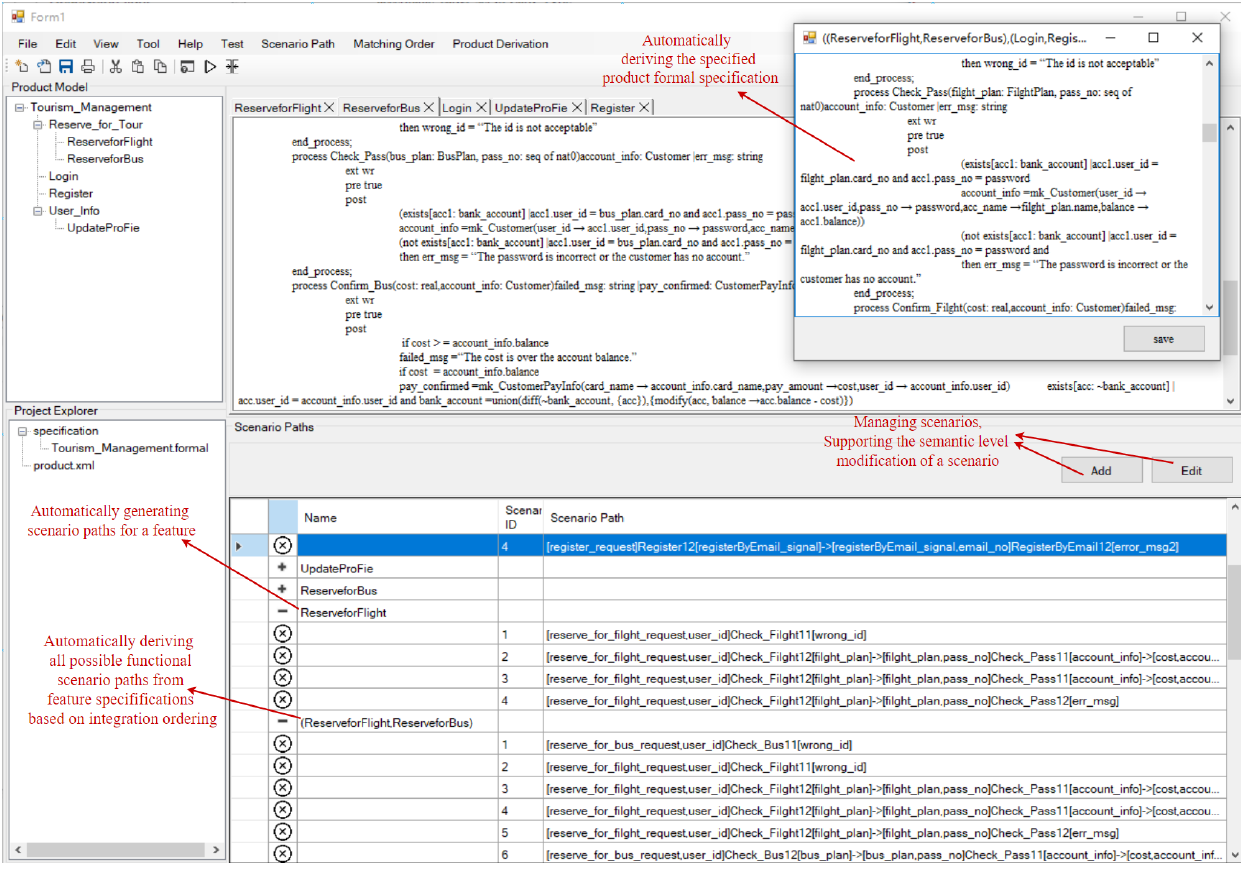
Figure 8. A snapshot of the